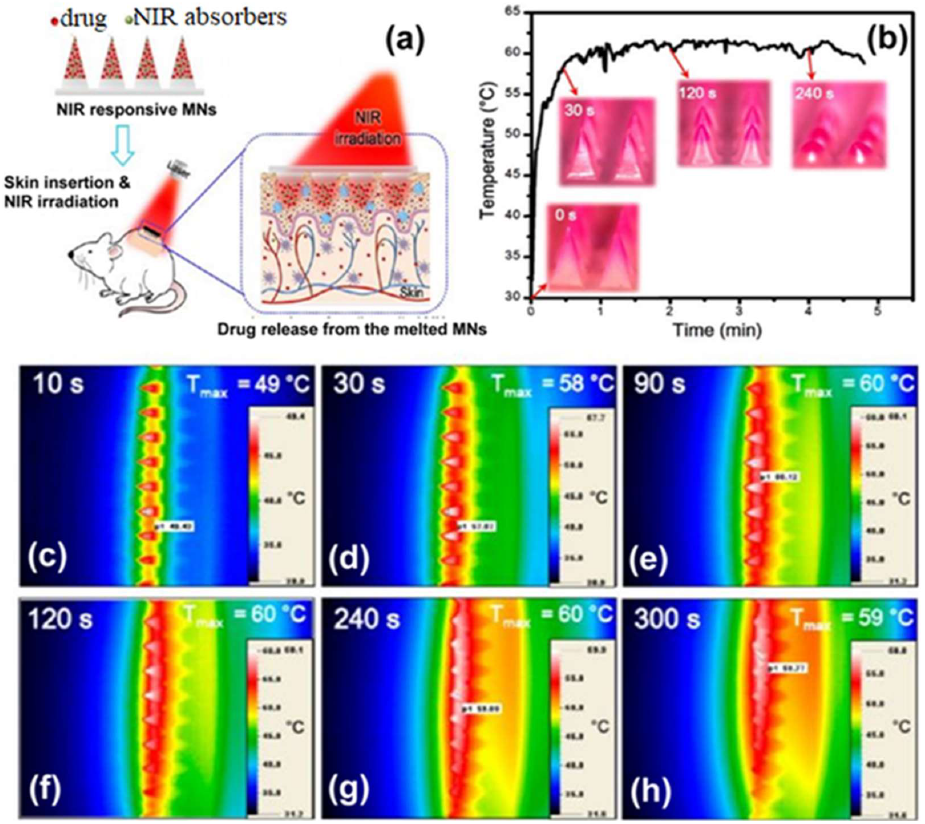
Figure 12. ( a ) Schematic illustrations of on-demand transdermal drug delivery using near-infrared (NIR) light-responsive microneedles (MNs), composed of polycaprolactone and NIR absorbers as well as silica-coated lanthanum hexaboride (LaB 6 -SiO 2 ) nanostructures. ( b ) Temperature changes of R6G-loaded microneedles after continuous exposure to 808 nm NIR laser light at an output power of 7 W cm −2 . ( c – h ) Infrared thermal images of microneedles after continuous irradiation for 10, 30, 90, 120, 240, and 300 s. The insets in ( b ) show the light-triggered melting behavior of microneedles [37].